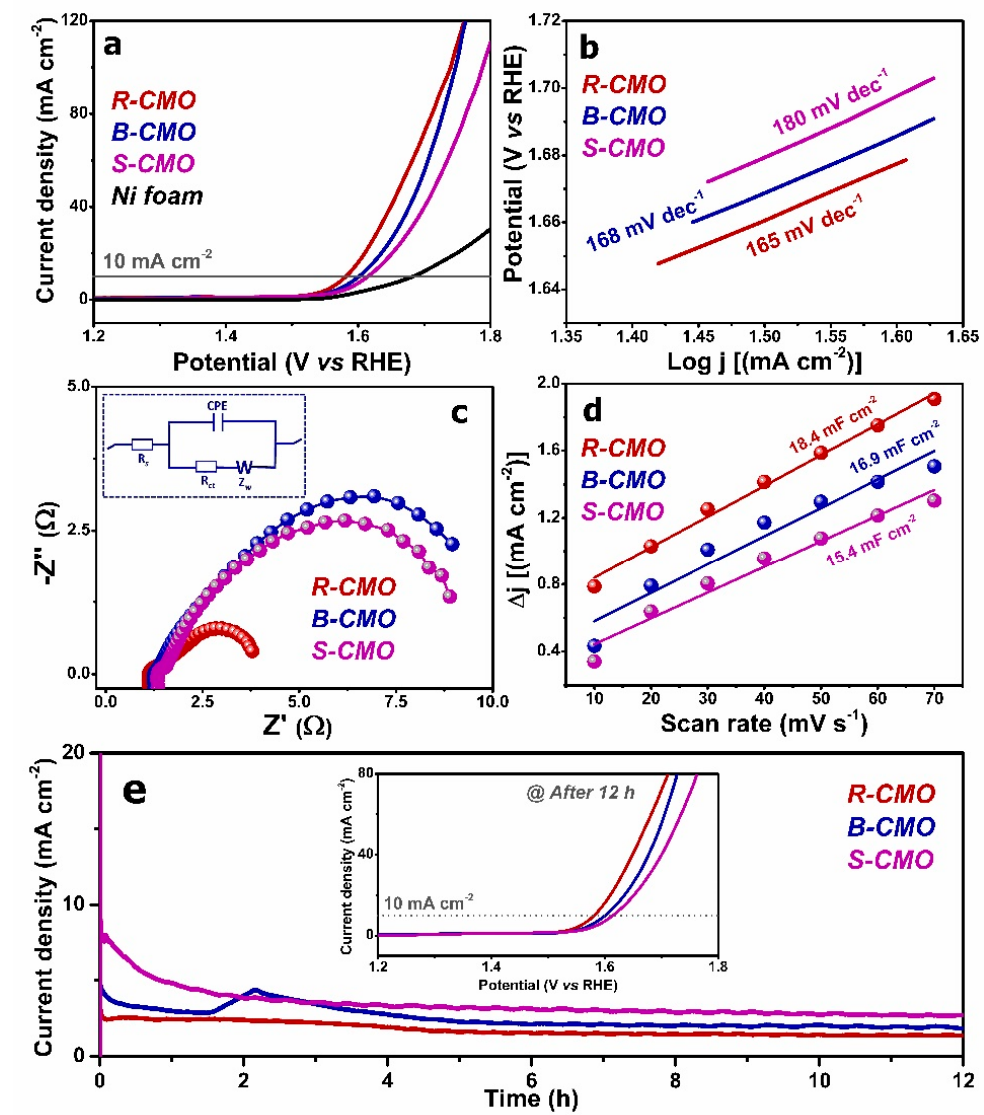
Figure 5. ( a ) Polarization curves, ( b ) Tafel curves, ( c ) EIS curves (Inset: equivalent circuit diagram), ( d ) current density differences vs. scan rates curves and ( e ) chronoamperometry stability test curves of CoMoO 4 nanostructured materials (Inset: Polarization curves after stability test). Table 1. Comparison of OER performance of present work with some of the representative non- noble catalysts.